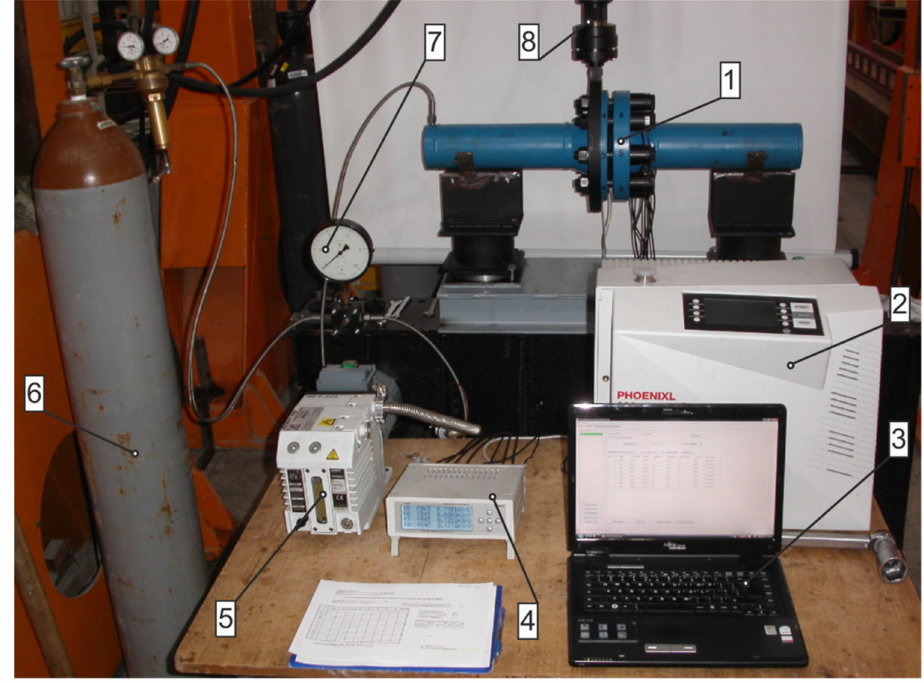
Figure 6. Test rig: 1—tested flanged-bolted joint; 2—helium detector; 3—PC recording the change in bolt tension; 4—strain-gauge amplifier; 5—vacuum pump; 6—cylinder with helium; 7—pressure gauge; 8—head connecting the hydraulic actuator with the tested